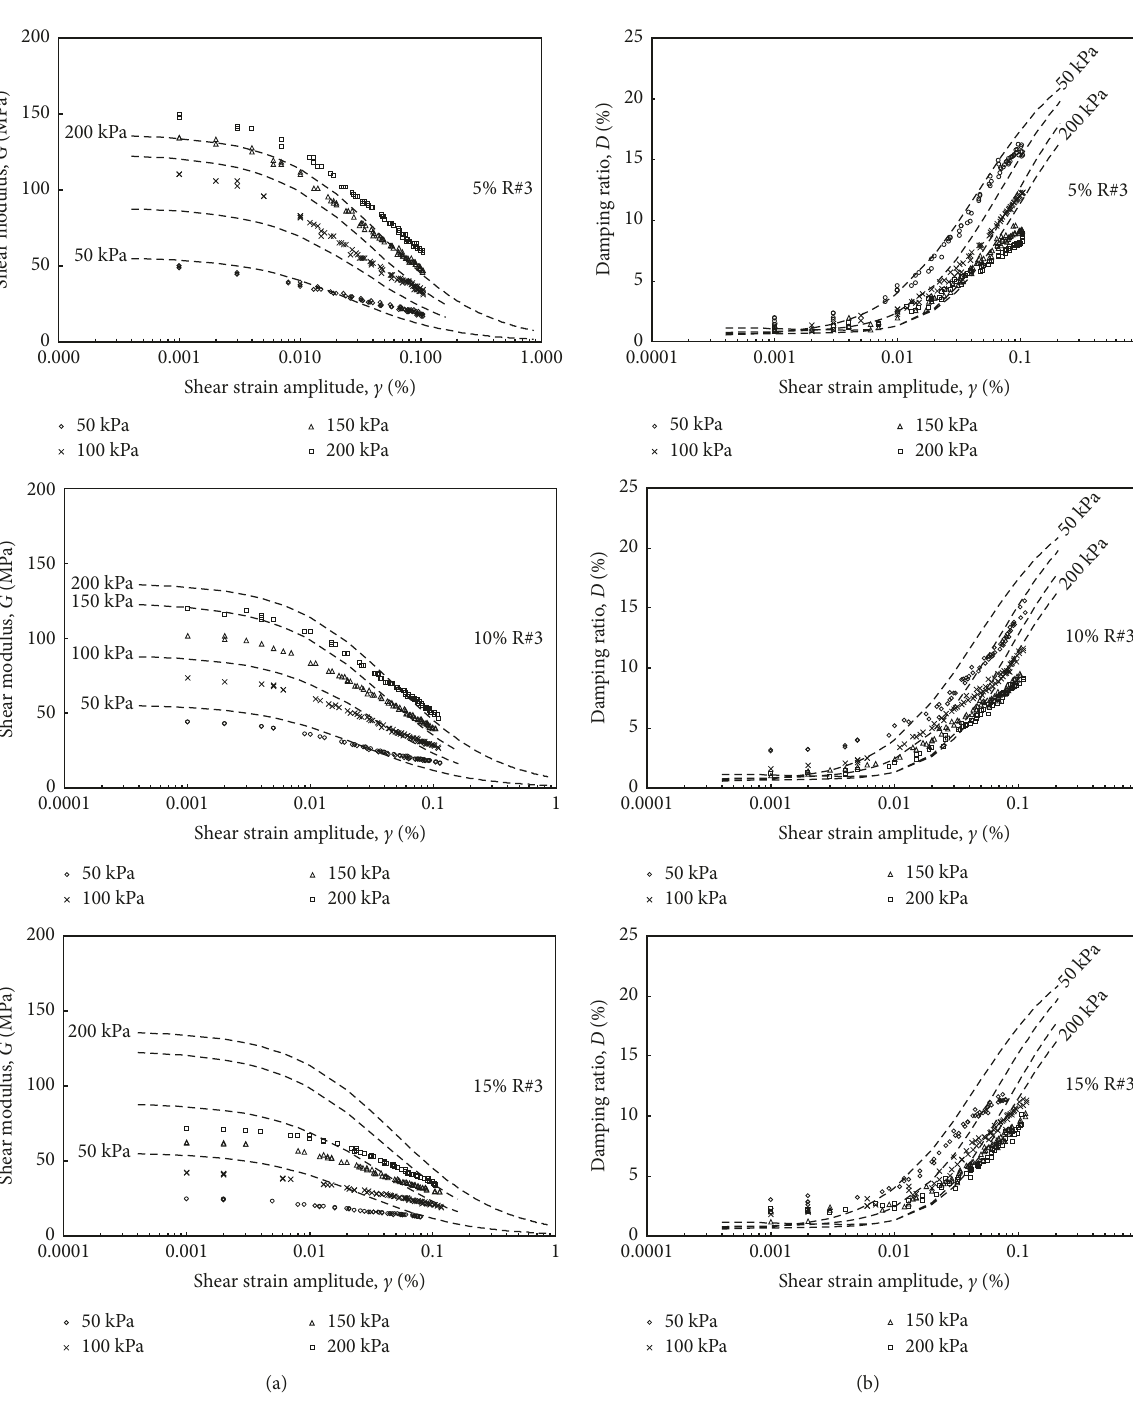
Figure 9: R#3 sand mixture: (a) strain-dependent shear modulus and (b) strain-dependent damping